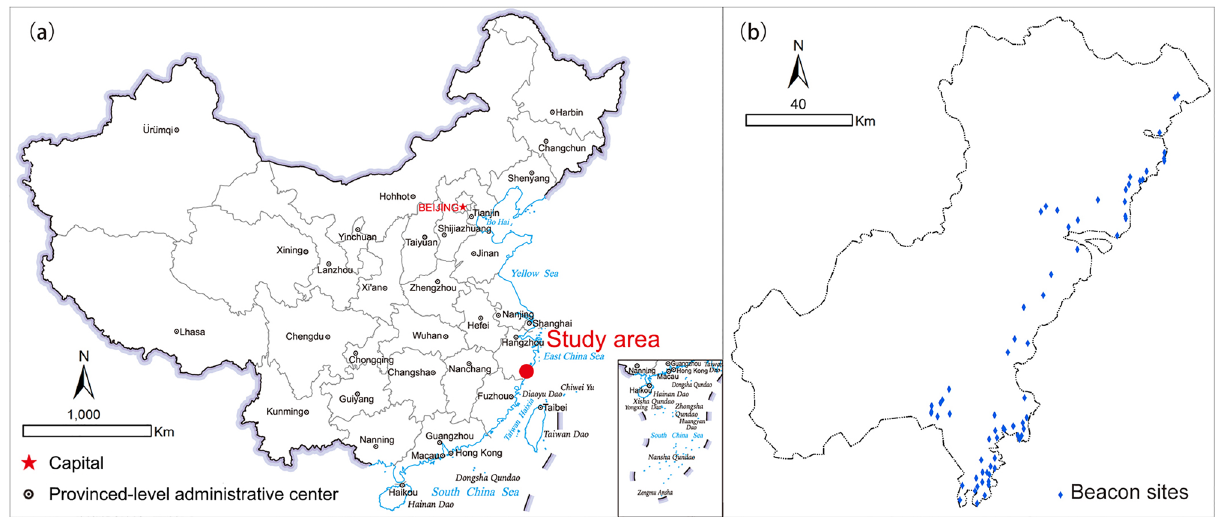
Figure 1. Study area: ( a ) location of Wenzhou (provided by Ministry of Natural Resources of China, Approval number: GS(2019)1673); ( b ) distribution of beacon sites (generated by the authors using ArcGIS